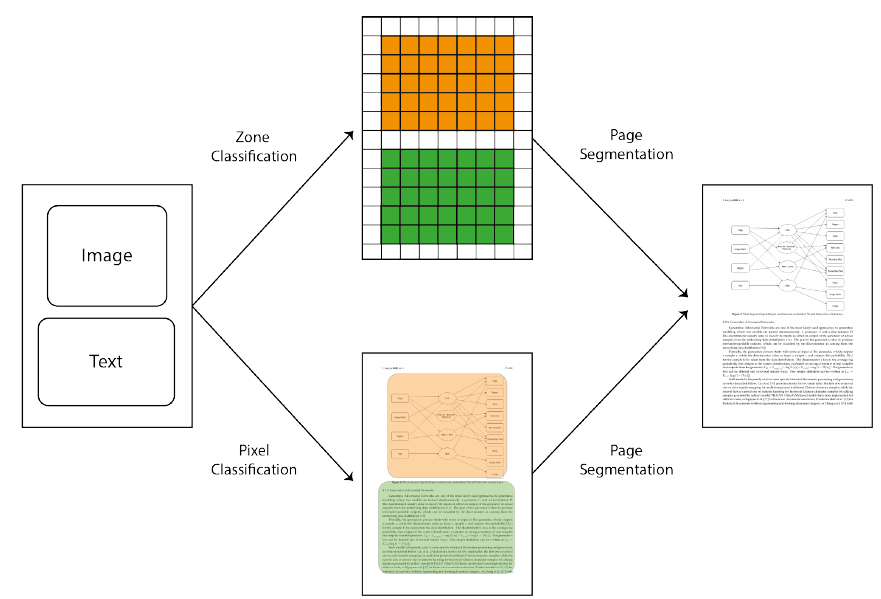
Figure 1. Zone (or patch) classification compared to pixel